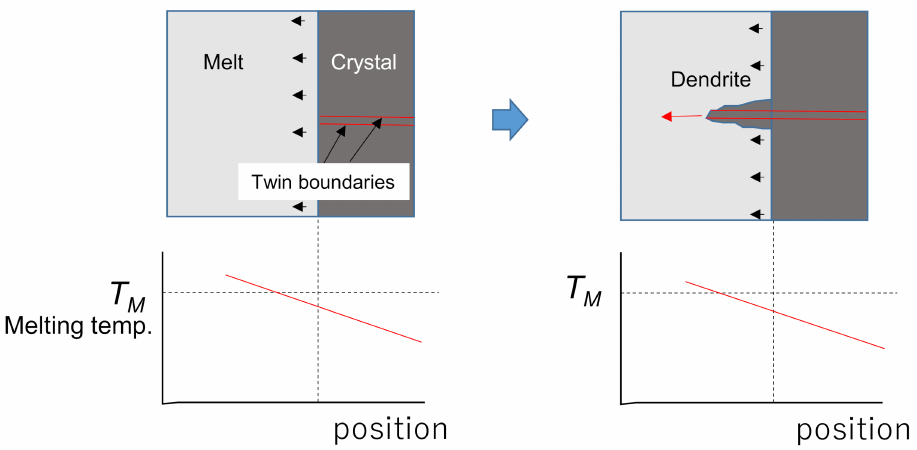
Figure 7. Formation of the dendritic interface due to the existence of parallel twin